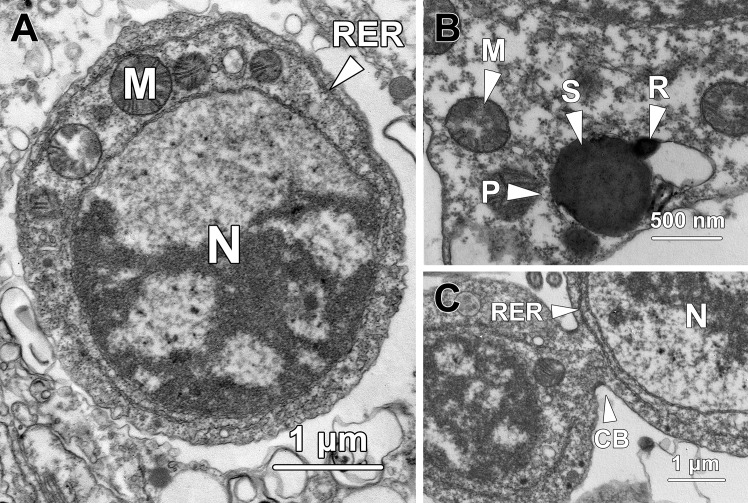
Transmission electron micrographs of step 5 spermatids.(A) As the nuclear size (N) of step 5 spermatids decreases, the decondensed chromosomes are aggregated into a retiform pattern. Large spherical mitochondria (M) are observed gathering at one end of the spermatids. RER, rough endoplasmic reticulum. (B) In the proacrosome (P) of step 5 spermatids, a ring-shaped structure (R) forms surrounding the sphere (S) at the centre. M, mitochondria; N, nucleus. (C) Step 5 spermatids remain interconnected by a cytoplasmic bridge (CB). A continuous profile of rough endoplasmic reticulum (RER) is found surrounding the nucleus.